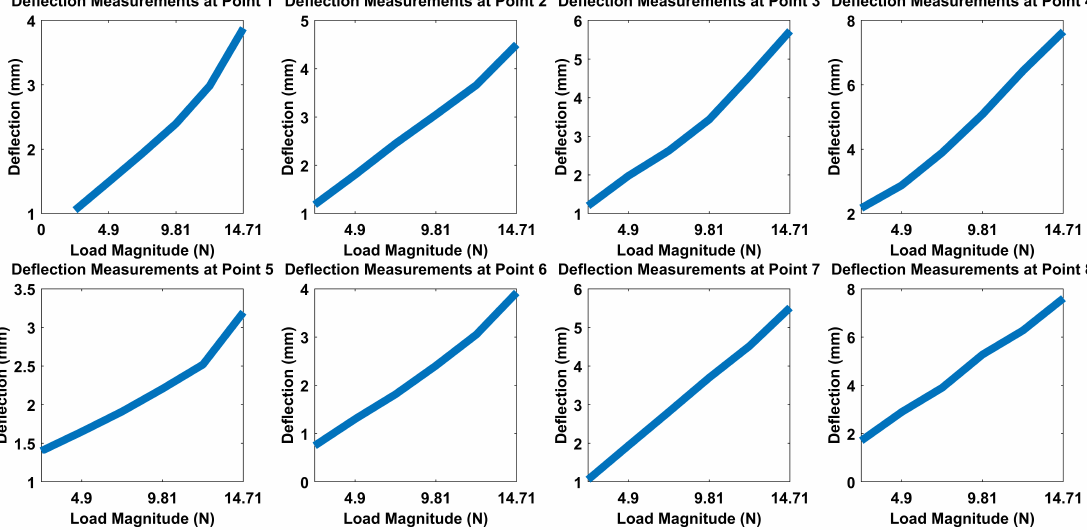
Figure A1. Deflection measurements for loads acting at point 2 of the wing.